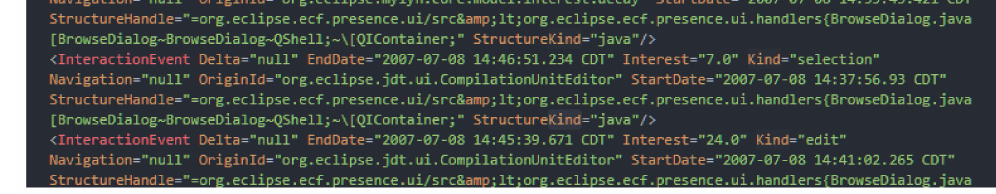
Figure 9. An example of Mylyn